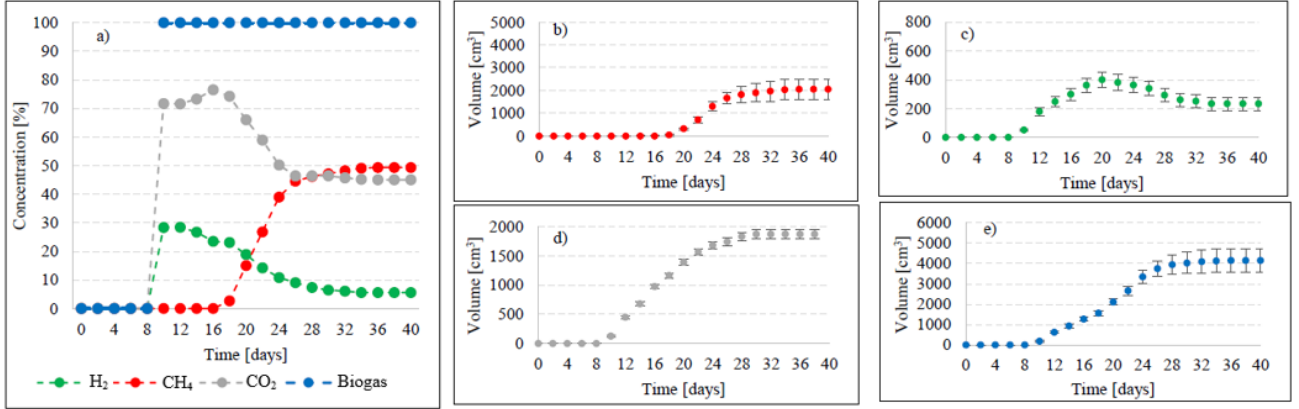
Figure 8. Changes in concentrations of biogas fractions in V6 ( a ); total volumes of CH 4 ( b ), H 2 ( c ), CO 2 ( d ), and biogas ( e ).